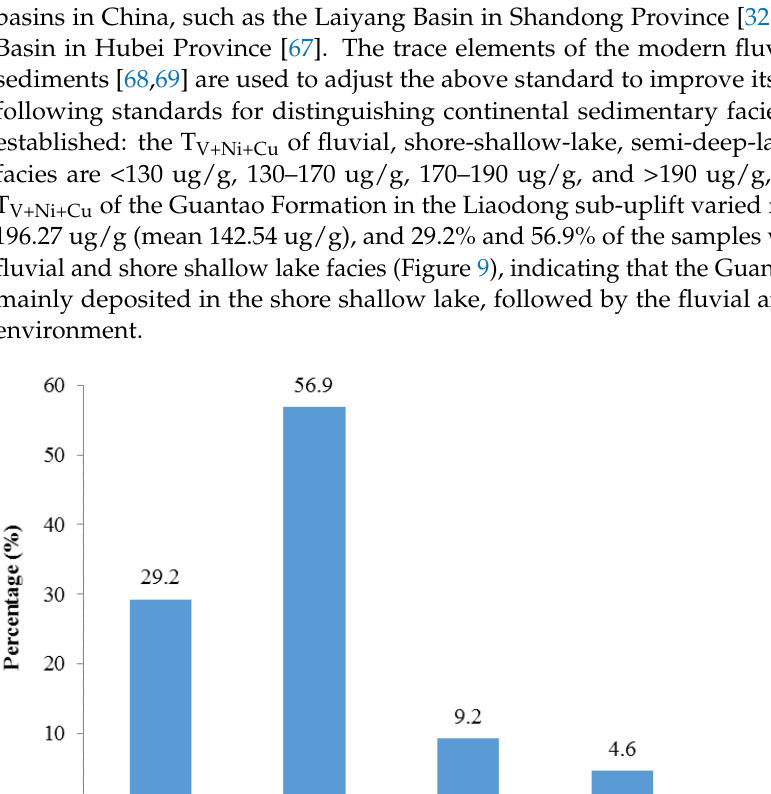
Figure 10. Lacustrine sedimentary type analysis chart [47] based on carbon and oxygen isotope val- ues.